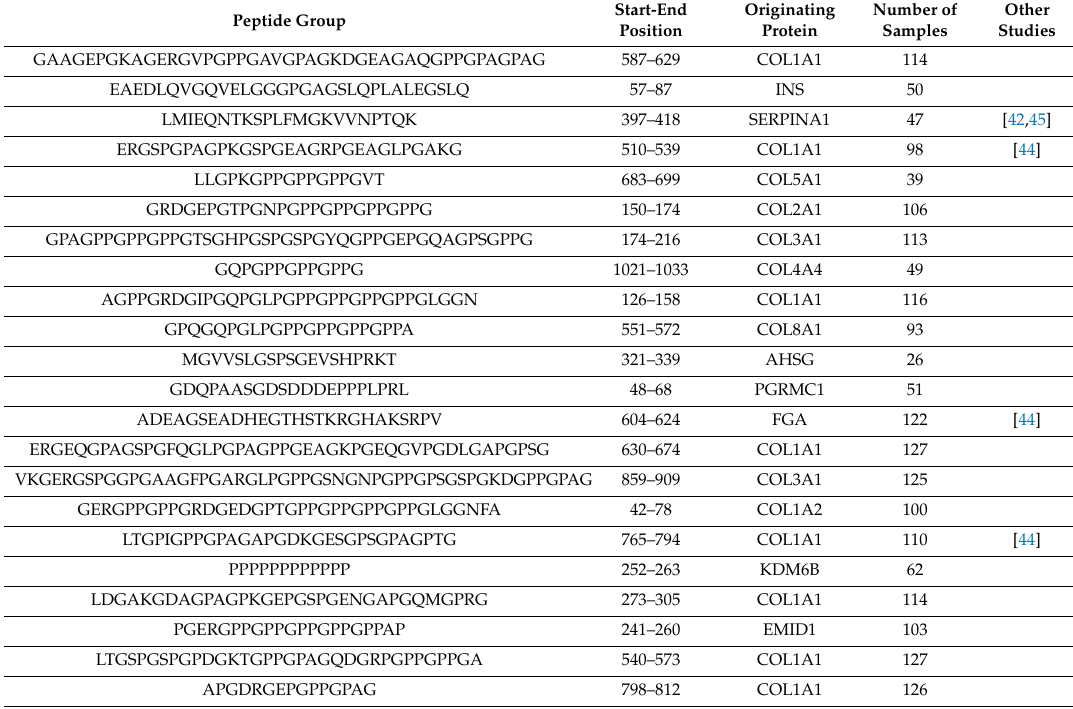
Table 4. Urine VIP-peptide groups mostly di ff erentiating mPE and sPE from control, CH, and GH samples.